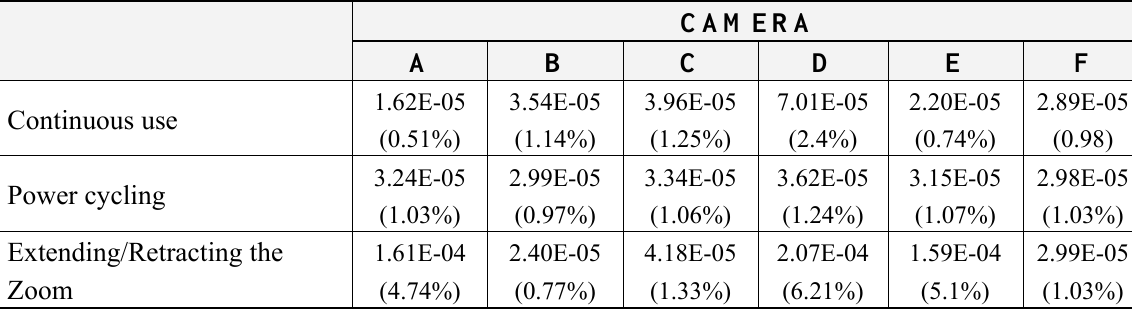
Table 5. Standard deviations of the first parameter of radial distortion obtained from the six cameras tested over the three situations studied. The value in parentheses is the relative standard deviation to the average